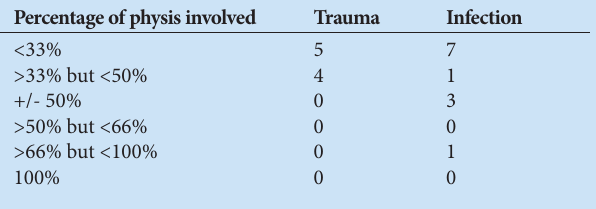
Table I. Distribution of physis involvement and